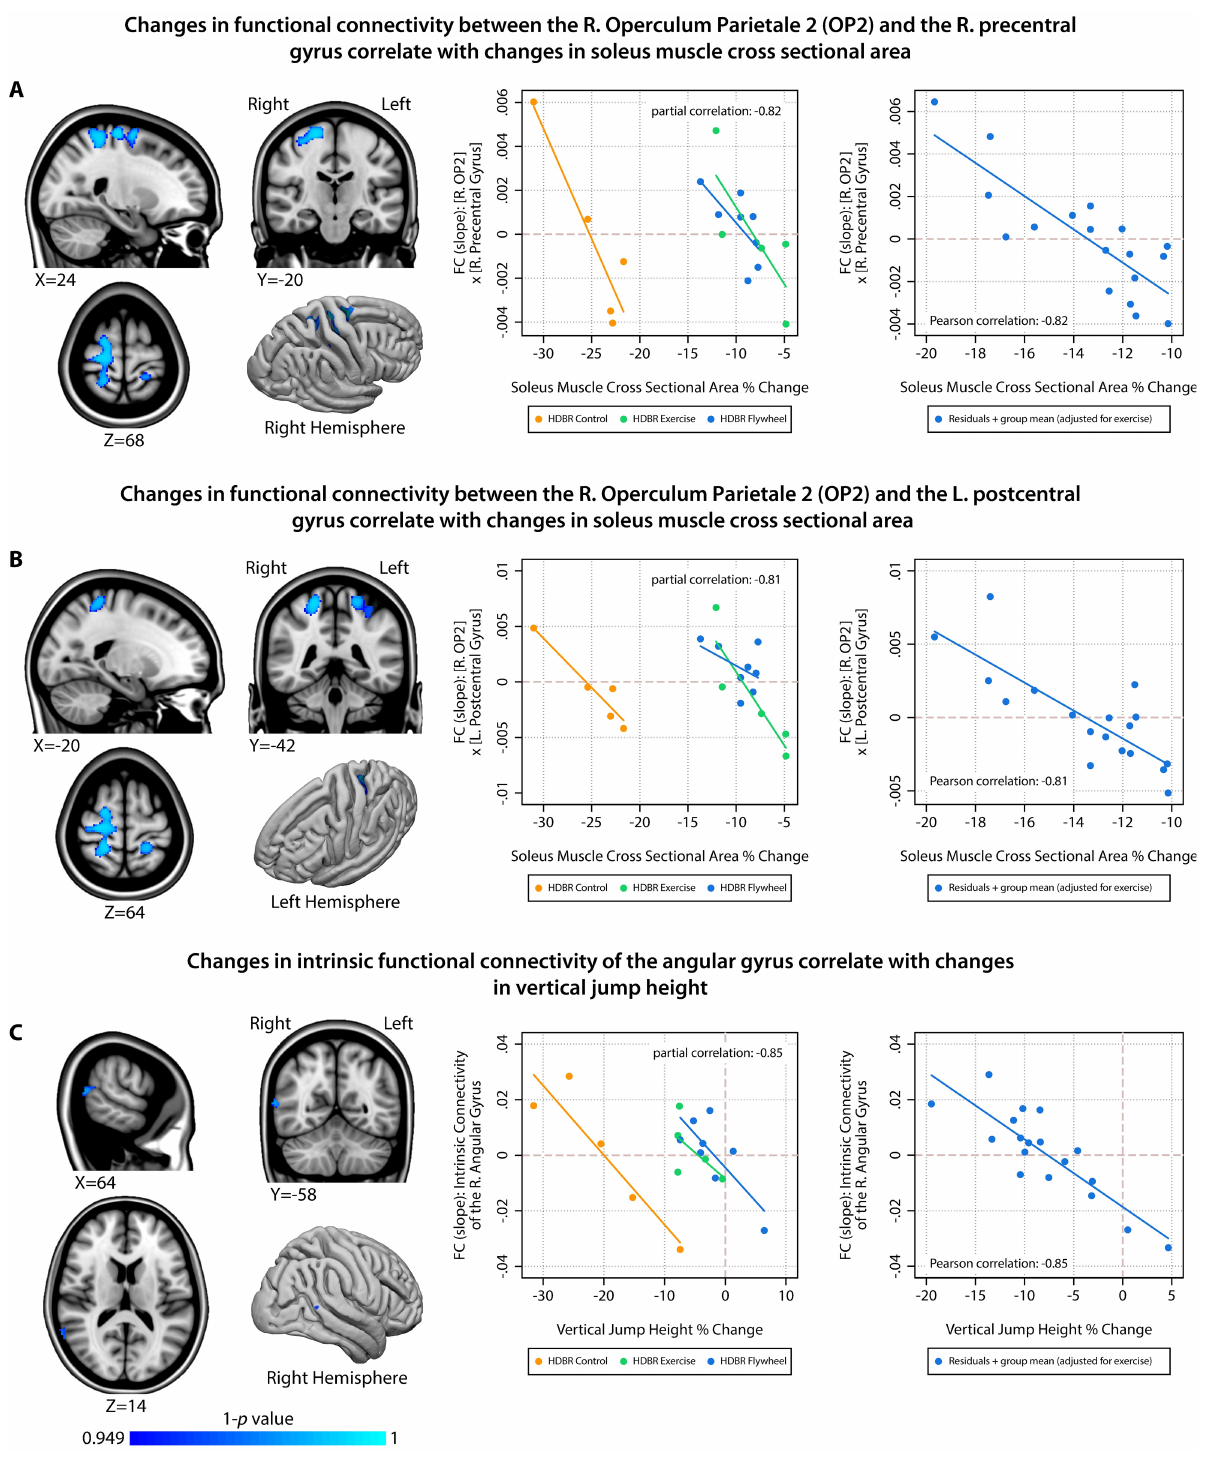
Fig 5. Associations between HDBR-induced changes in brain outcome measures and changes in physical fitness (part 2). Left column = overview of locations showing significant associations between changes in physical fitness and changes in brain measures; Middle column = scatterplot with fit lines showing correlations at the peak voxel stratified by HDBR group; Right column = scatterplot with fit line showing correlations at the peak voxel adjusted for exercise; R. = Right; FC = Functional Connectivity; L. = Left.